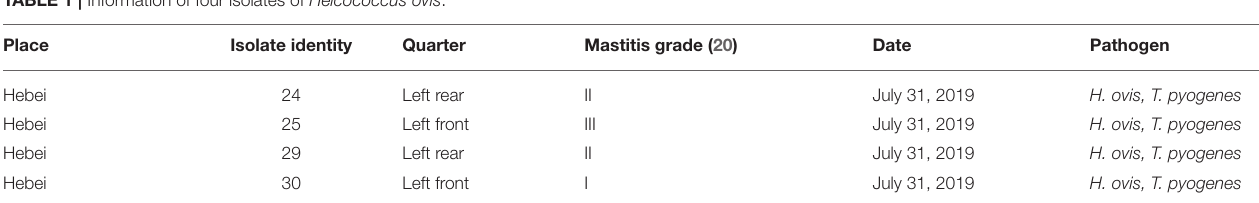
TABLE 1 | Information of four isolates of Helcococcus ovis